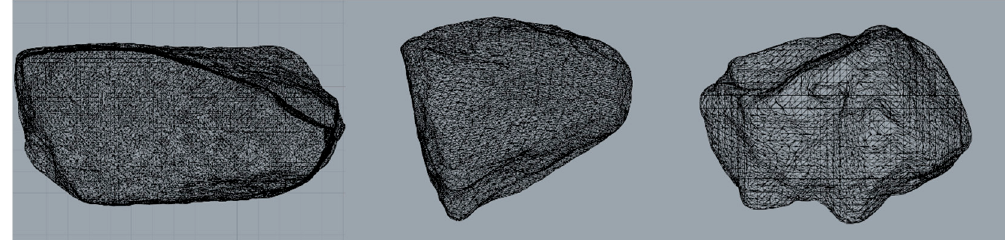
Figure 8. Aggregate numerical profile.